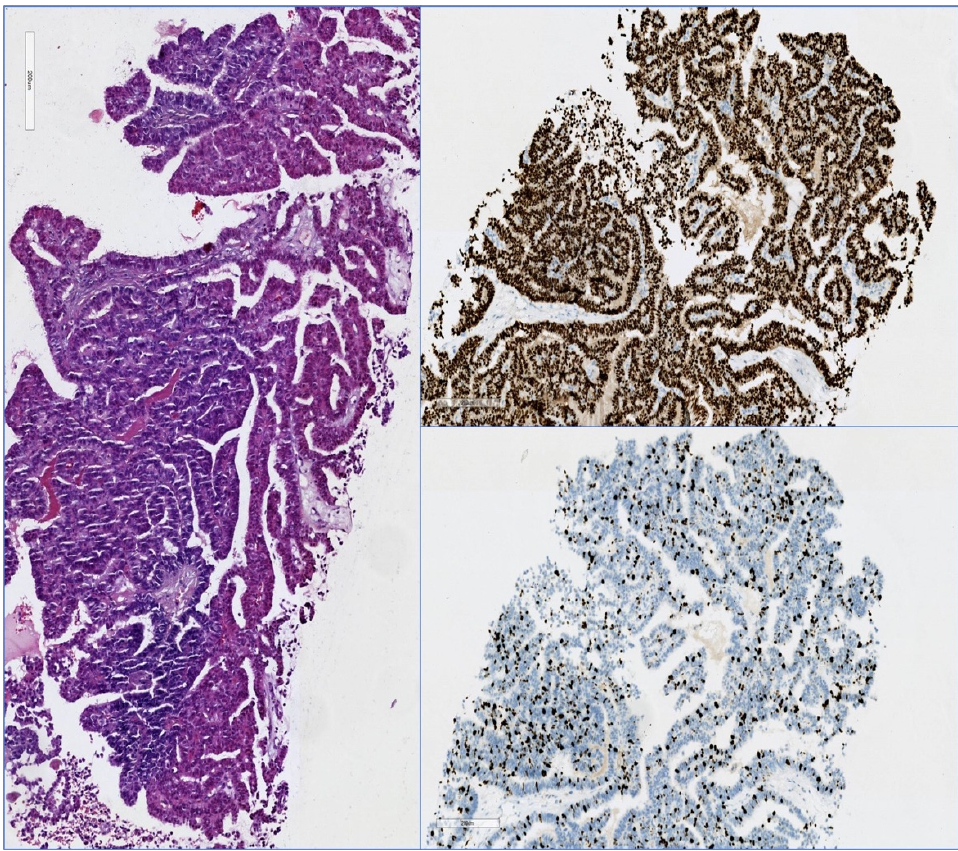
Figure 2. Biopsy sample from a breast tumor of a male 66 y.o.: left panel: papillary carcinoma of the breast, HE, 100×, top right panel: estrogen receptor positive in tumor cells nuclei (Allred score: 8), bottom right panel: Ki-67 positive in ~75% of the tumor cells nuclei, IHC, 100×.